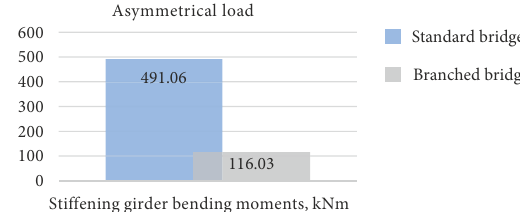
Figure 12. The results of the analysis of the bending moments in the stiffening girder. The blue colour indicates the standard bridge data, the grey colour – the branched bridge data